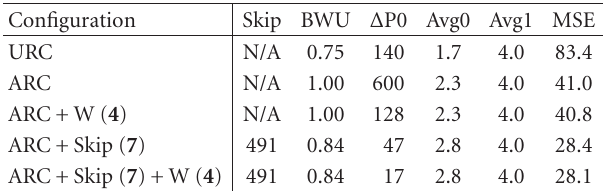
Table 1: Experimental results comparing URC with various ARC configurations.